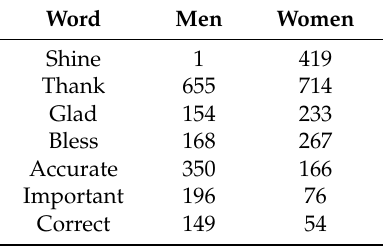
Table 2. Differences in positive words between men and women.